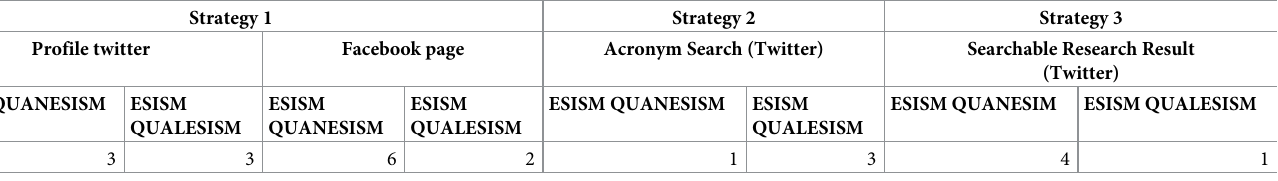
Table 14. Amount of each type of evidence for each search